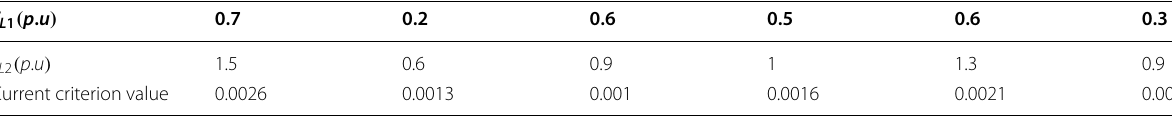
Table 5 Current criteria value in different mechanical load changes